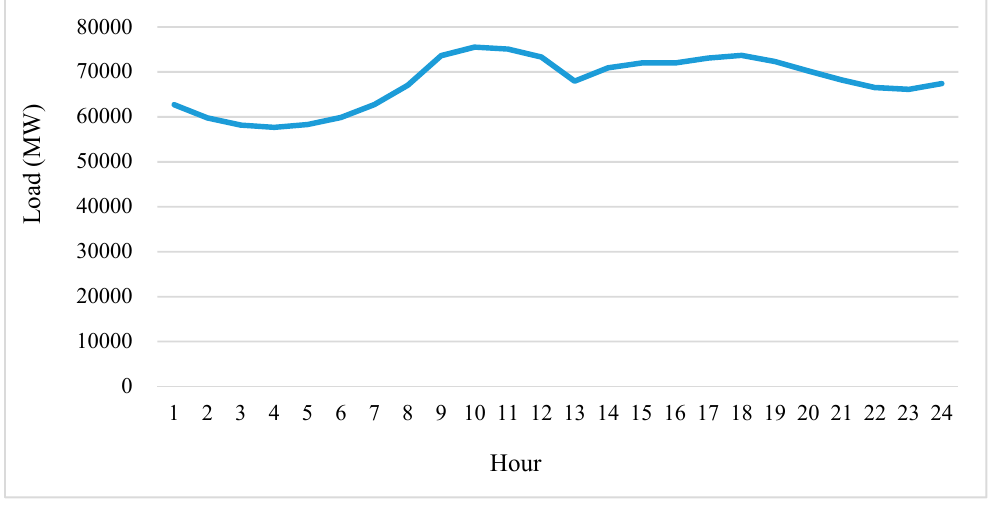
Figure 2. Load profiles of peak day in 2016.